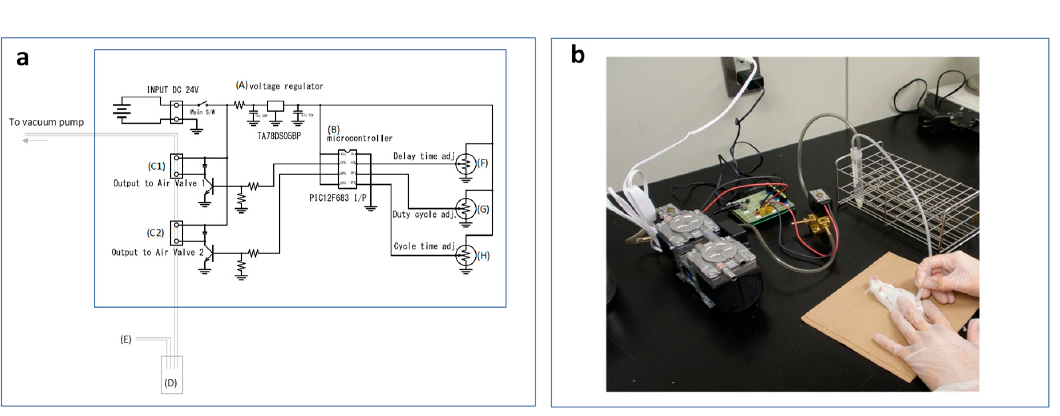
Figure 1. Mouse milking device. ( a ). Schematic circuit diagram of milking device. Voltage regulator (A), a microcontroller (B), two solenoid valves (C1 and C2), a milk-receiving tube (D), a teat cup (E),